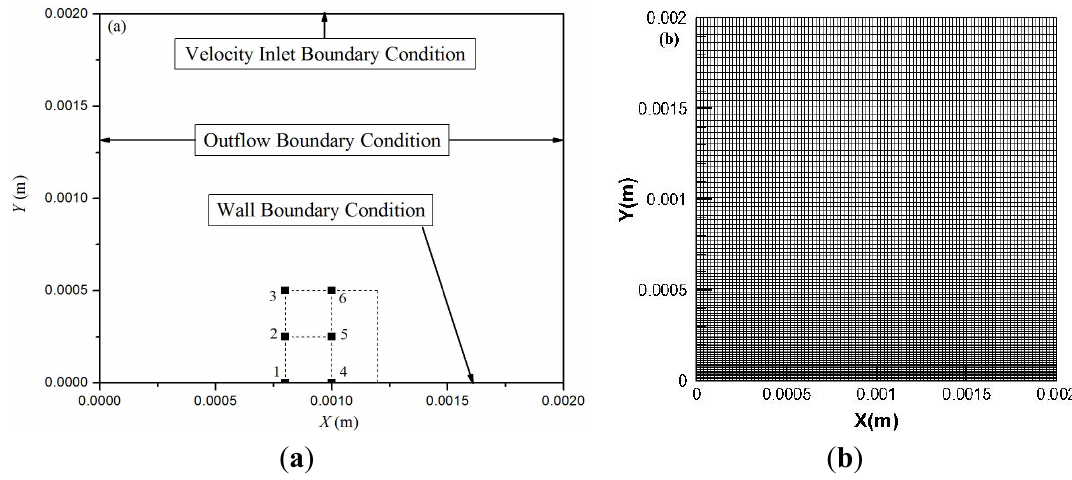
Figure 2. ( a ) The numerical computational region and boundary condition and, ( b ) the mesh of the computational model.